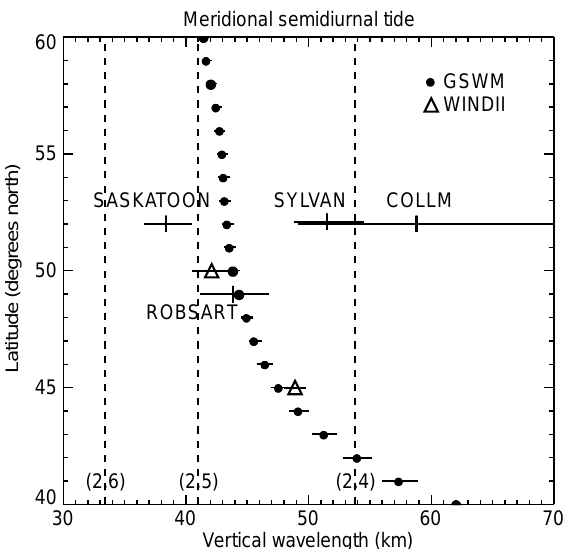
Fig. 9. Estimated vertical wavelength of the meridional semidiurnal tide between 80 and 110 km. The vertical wavelength for the (2,4), (2,5) and (2,6) semidiurnal tidal modes computed from classical tidal theory are provided as a reference ( dashed lines )